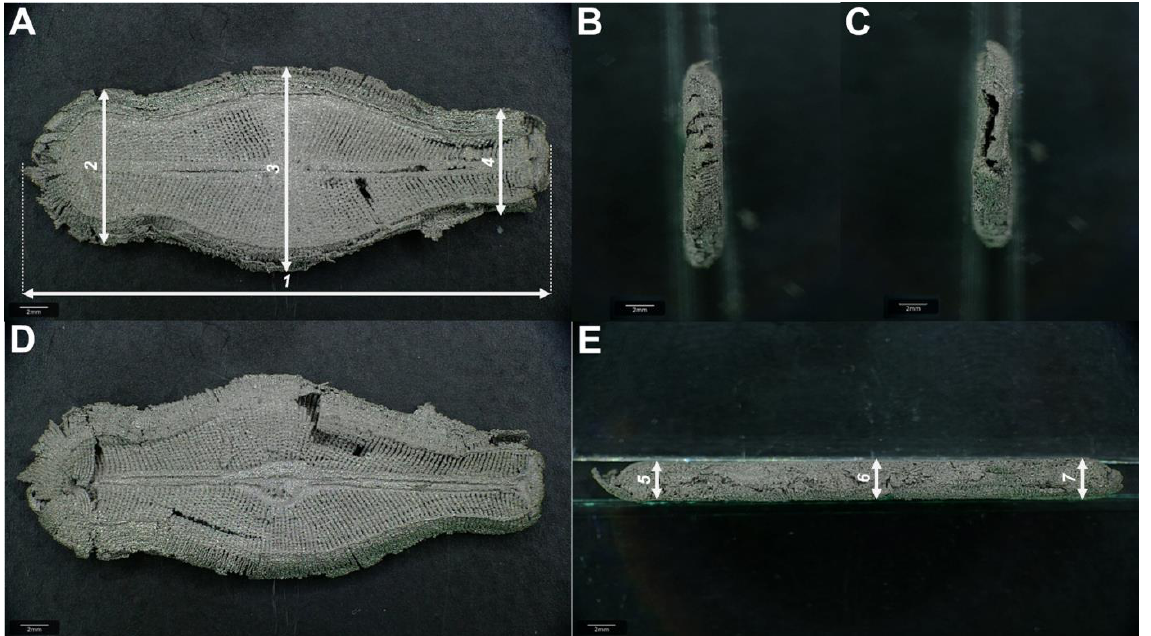
Figure 4. Photos of the printed, engineered object based on the design of frustule of Didymosphenia geminata after compression test: ( A , D ) valve view; ( B ) headpole ending; ( C ) footpole ending; ( E ) girdle band view with designations: 1 — length; 2 — width of the headpole, 3 — width in the middle part; 4 — width of the footpole; 5 — thickness in the headpole; 6 — thickness in the middle part; 7 — thickness in the footpole.